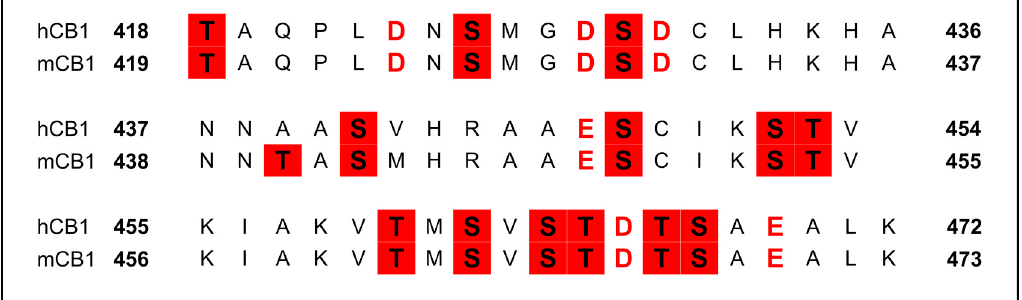
Figure 2. Sequence alignment (hCB1 / mCB1) of the C-terminus of CB1. Negatively-charged residues are in red, possible phosphorylation sites are highlighted red.